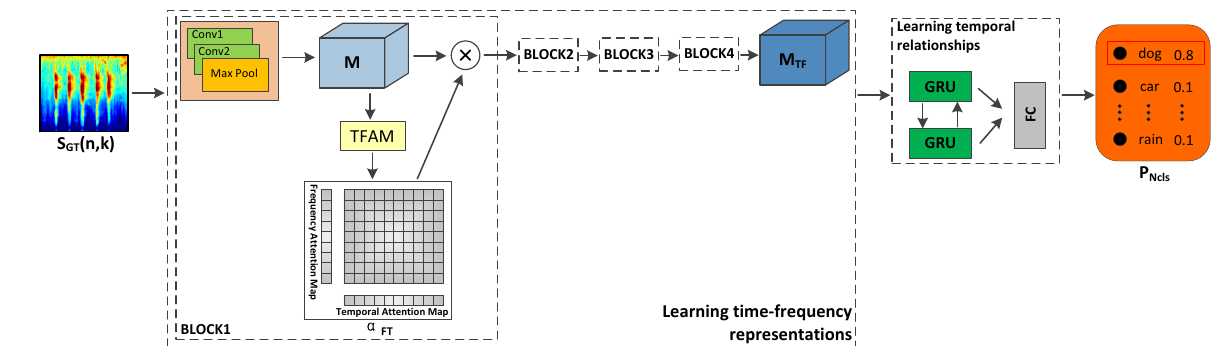
Figure 4. Illustration of our proposed environmental sound classification framework with temporal-frequency attention mechanism (TFAM).